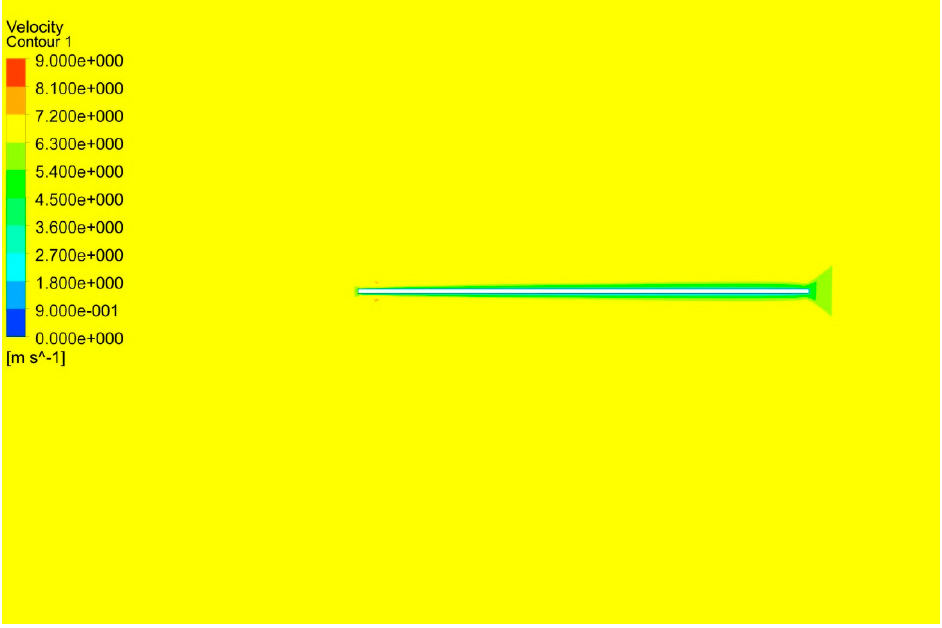
Figure 14. Velocity contour of PVEH plate without bluff splitter body under 7 m/s wind speed.